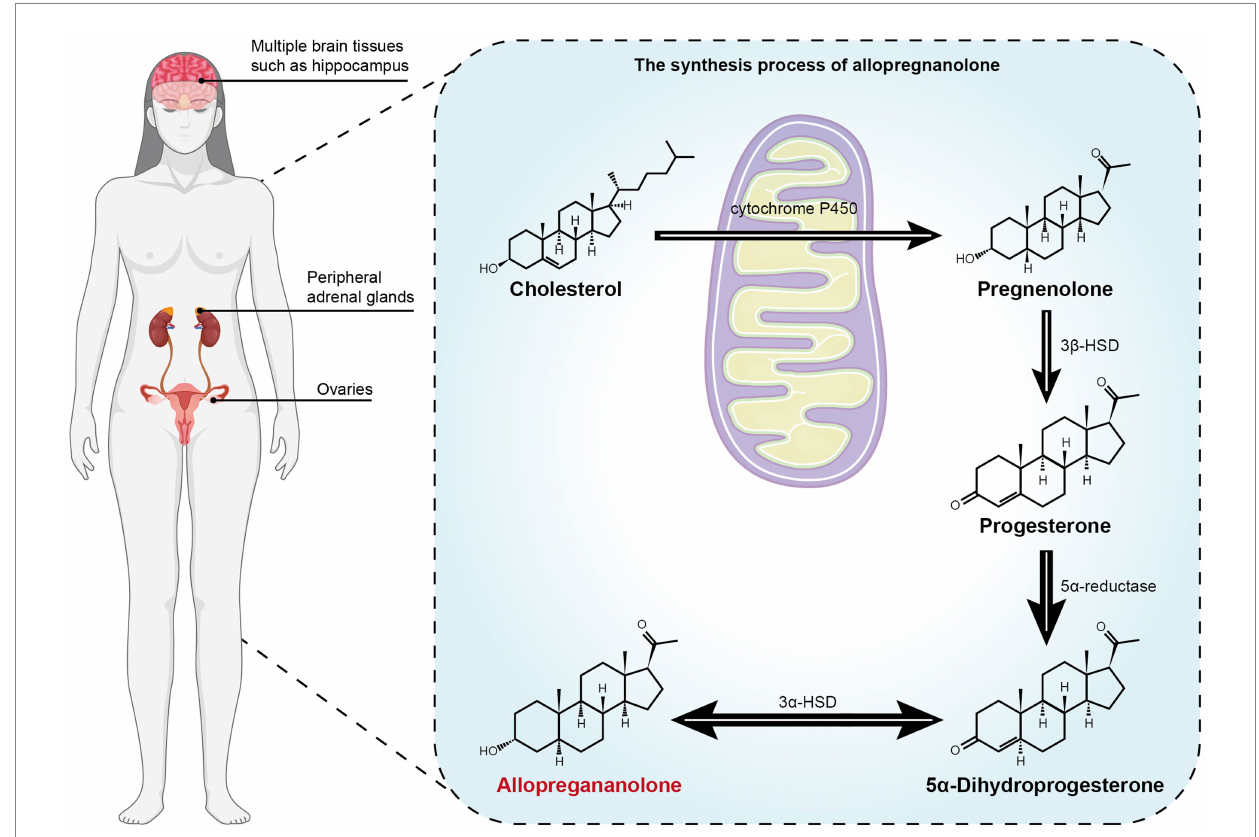
FIGURE 1 The metabolism process of the precursor cholesterol to allopregnanolone. Cholesterol is transported to the inner mitochondrial membrane through the 18-kDa transport protein TSPO, and then through the cytochrome P450 cholesterol side-chain lyase P450 (P450scc) to produce pregnenolone. Progesterone is produced from pregnenolone by 3 β -hydroxysteroid dehydrogenase (3 β -HSD) metabolism, and then the metabolized products are gradually reduced by 5 α -reductase and 3 α -HSD (25). Allo is synthesized in brain (such as hippocampus), adrenal gland and gonad (24,